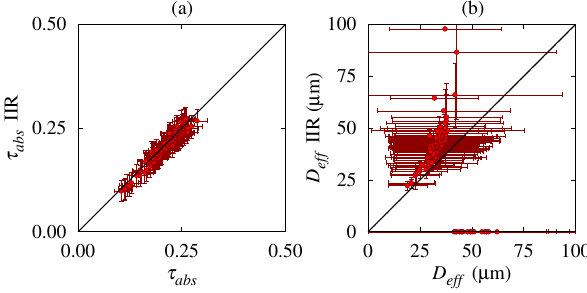
Fig. 4. Scatterplots of our retrievals results versus IIR operational products, compared pixel per pixel along the 16 May 2007 leg. (a) The absorption optical thicknesses with their uncertainties. (b) The effective diameters with their uncertainties. Only opera- tional retrievals obtained with an upper layer composed exclusively of high ST layers are